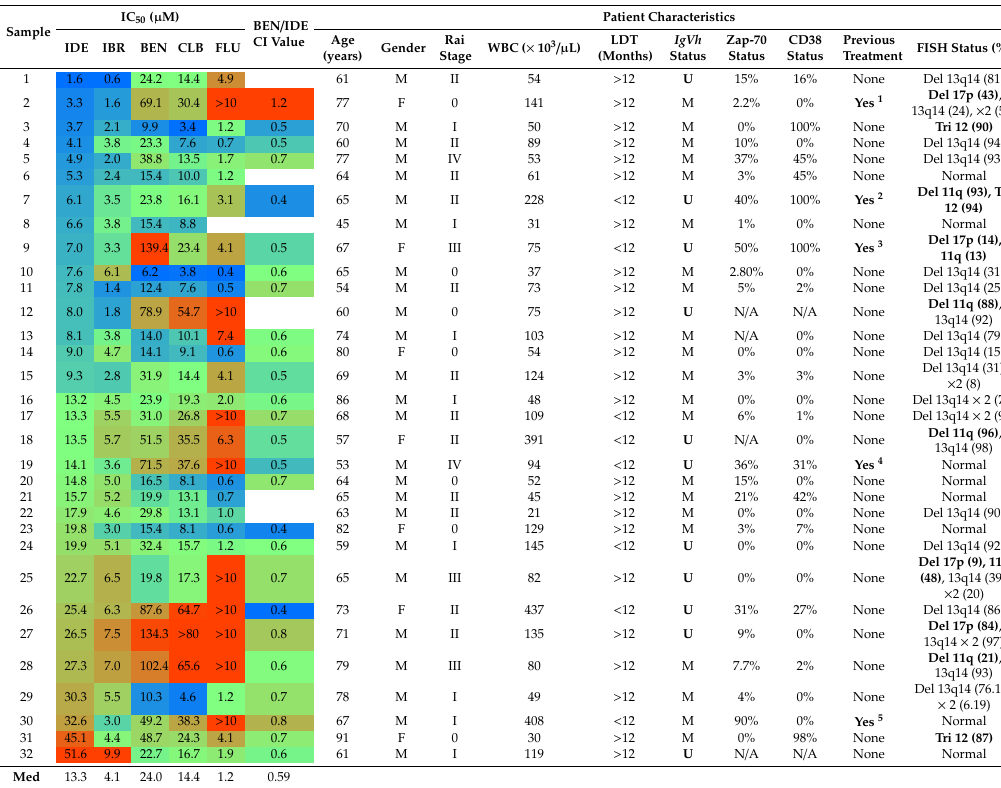
Table 1. Idelalisib (IDE) displays cross resistance with ibrutinib (IBR), not bendamustine (BEN), chlorambucil (CLB) or fludarabine (FLU), resistance to IDE is not predicted by previous treatment of the patient or deletion (del) 17p. The concentration required to inhibit viability by 50% (IC 50 ) (blue—sensitivity, red—resistance)andcombinationindex(CI)values(blue—synergy, green—additivity, red—antagonism) from the combination of BEN and IDE at the clinically relevant concentrations (average of 10 and 20 µ M for BEN and 5 µ M for IDE) of primary chronic lymphocytic leukemia (CLL) cells 72 h post drug